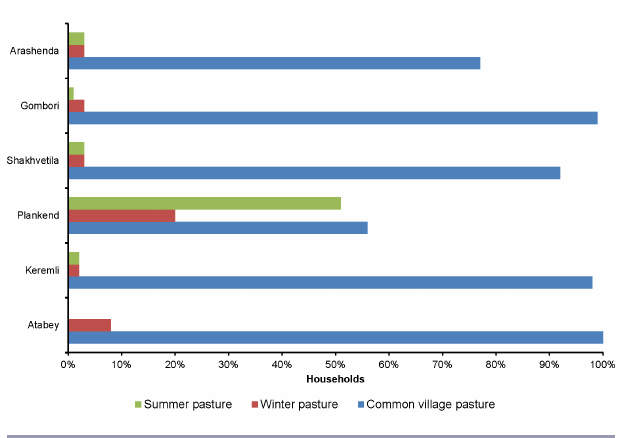
Fig. 7 . Use of grazing resources by village households (n =